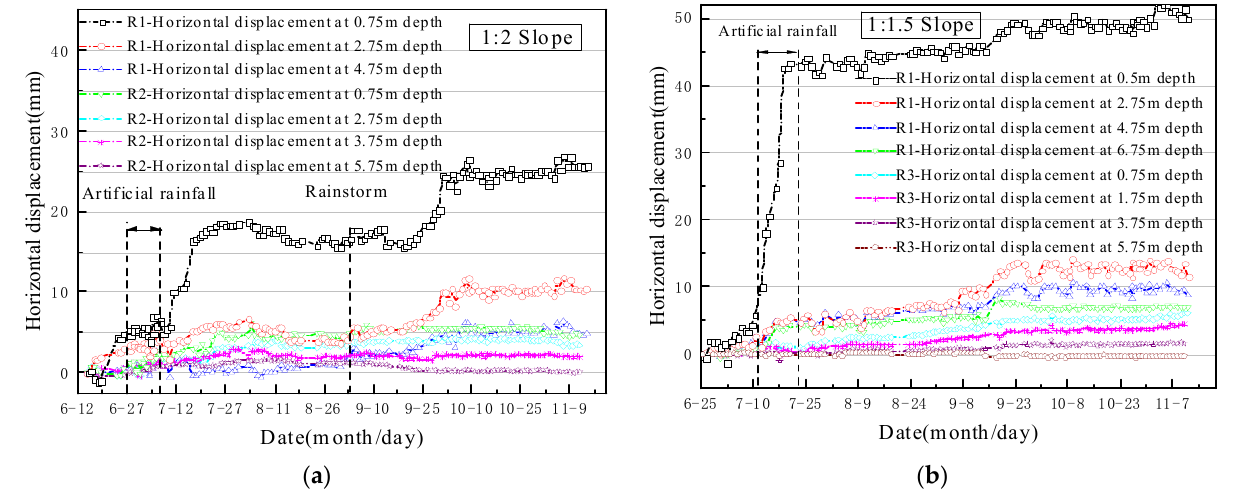
Figure 10. Horizontal displacement analysis: ( a ) 1:2 natural slope horizontal displacement variation trend; ( b ) 1:1.5 natural slope horizontal displacement variation trend.